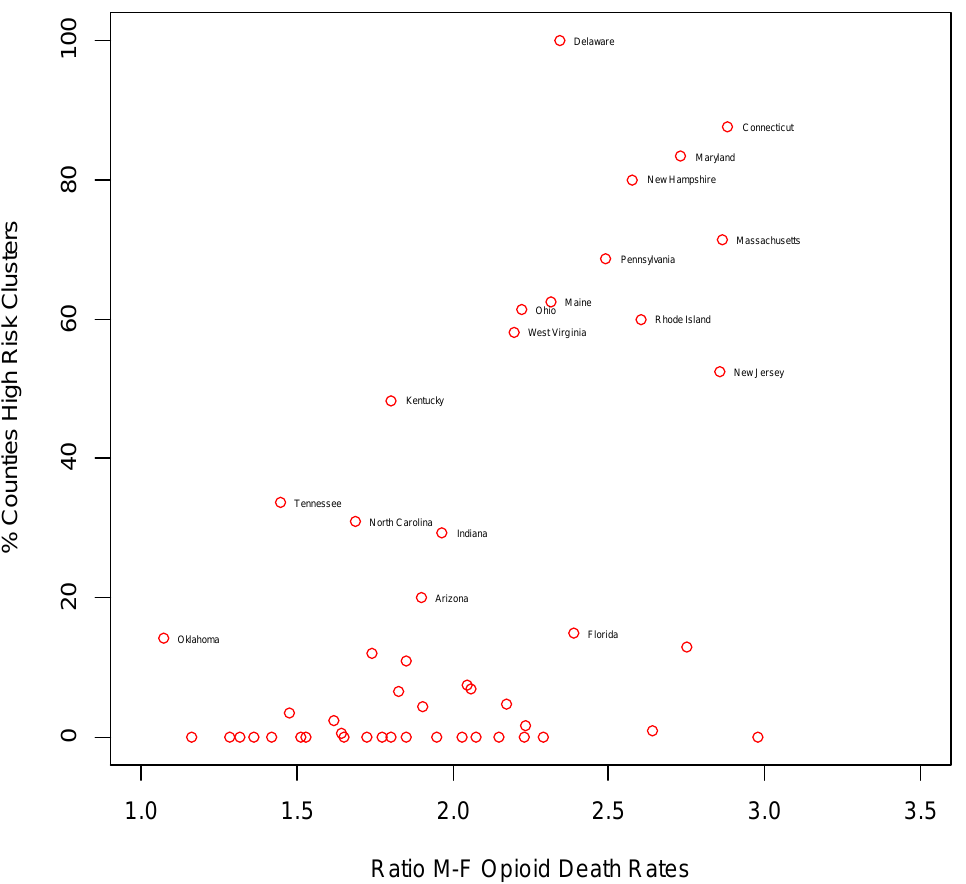
Figure 2 Male-Female Opioid Mortality Ratio and High Risk Drug Death Clustering